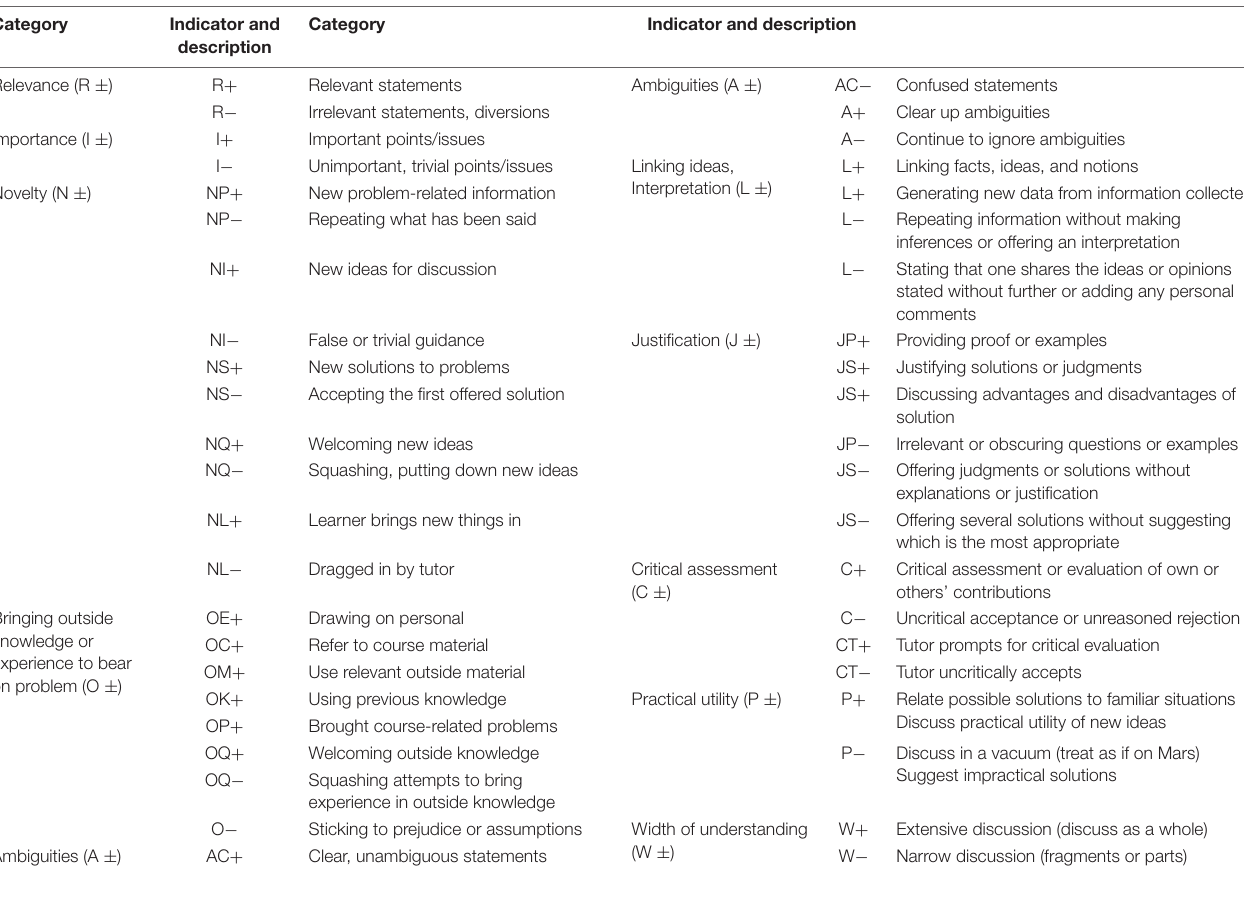
TABLE 2 | Newman’s critical thinking framework (Newman et al.,